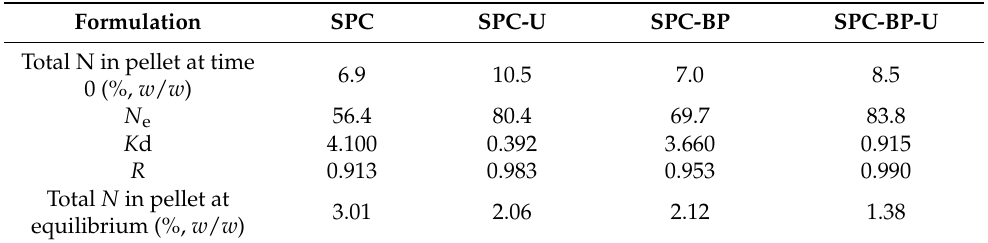
Table 9. Results from the interpolation of Figure 10 data with Equation (1): Constants ( N e and K d), and correlation coefficient ( R ).